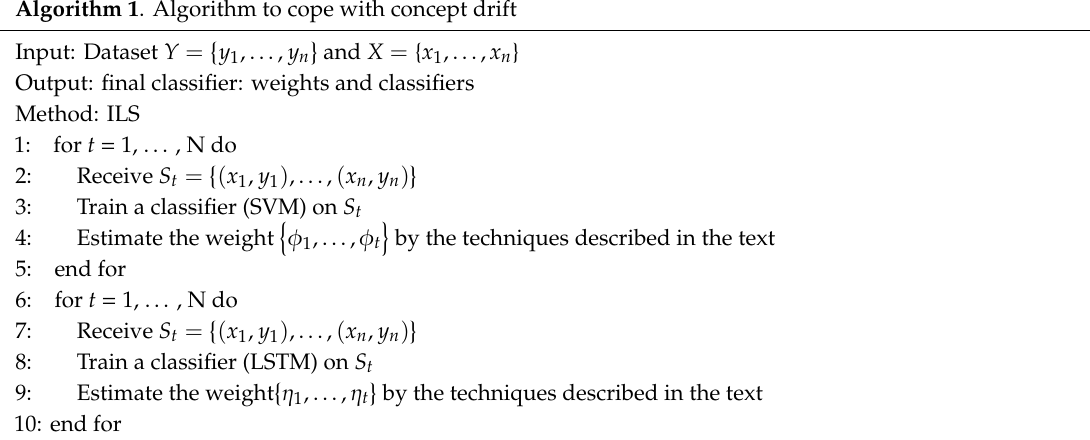
Algorithm 1 . Algorithm to cope with concept